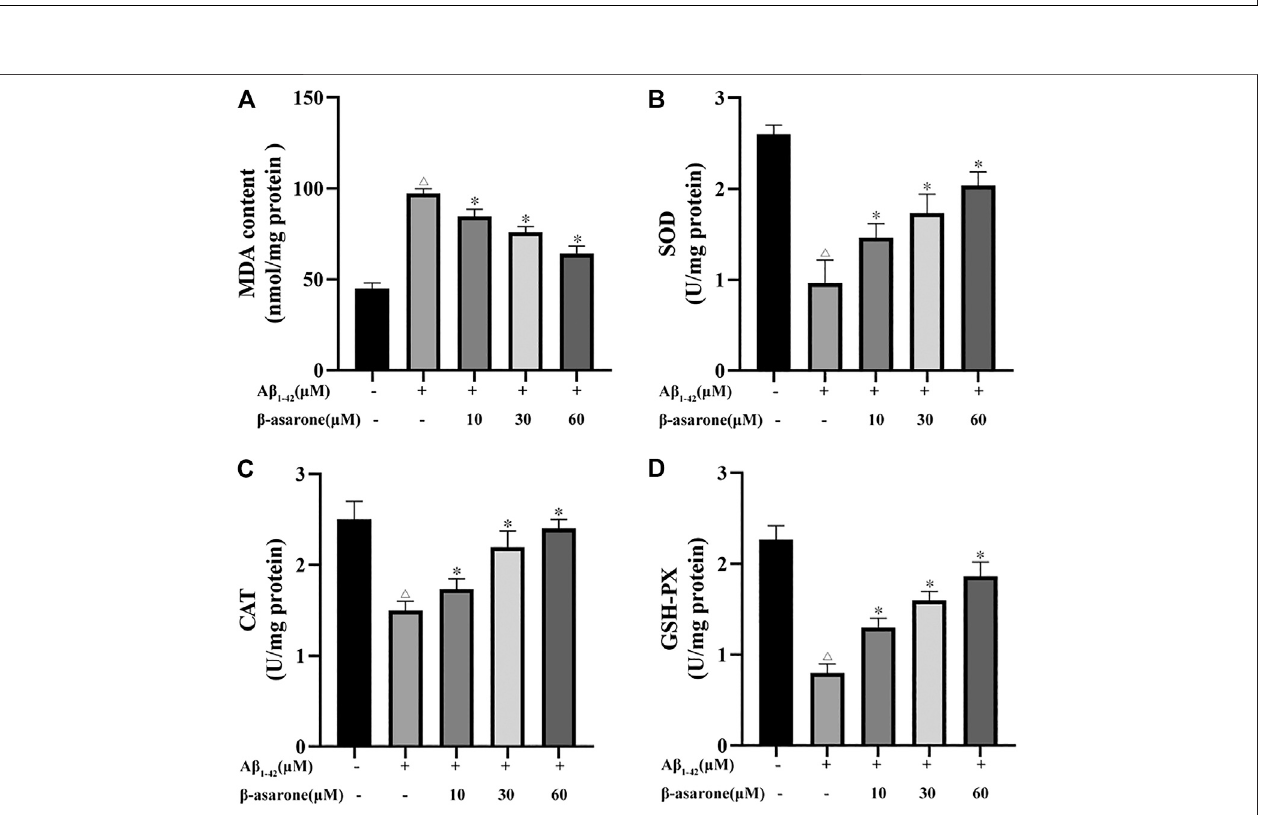
FIGURE 4 | Effect of β -asarone on A β 1 – 42 -induced oxidative stress. (A) Effect of β -asarone on A β 1 − 42 -induced MDA levels. (B) Effect of β -asarone on A β 1 − 42 - induced SOD levels. (C) Effect of β -asarone on A β 1 − 42 -induced CAT levels. (D) Effect of β -asarone on A β 1 − 42 -induced GSH-PX levels. △ p < 0.05 compared with the control group; * p < 0.05 compared with the A β 1 – 42 -alone treatment group. Data from three independent experiments were expressed as mean ± SD.